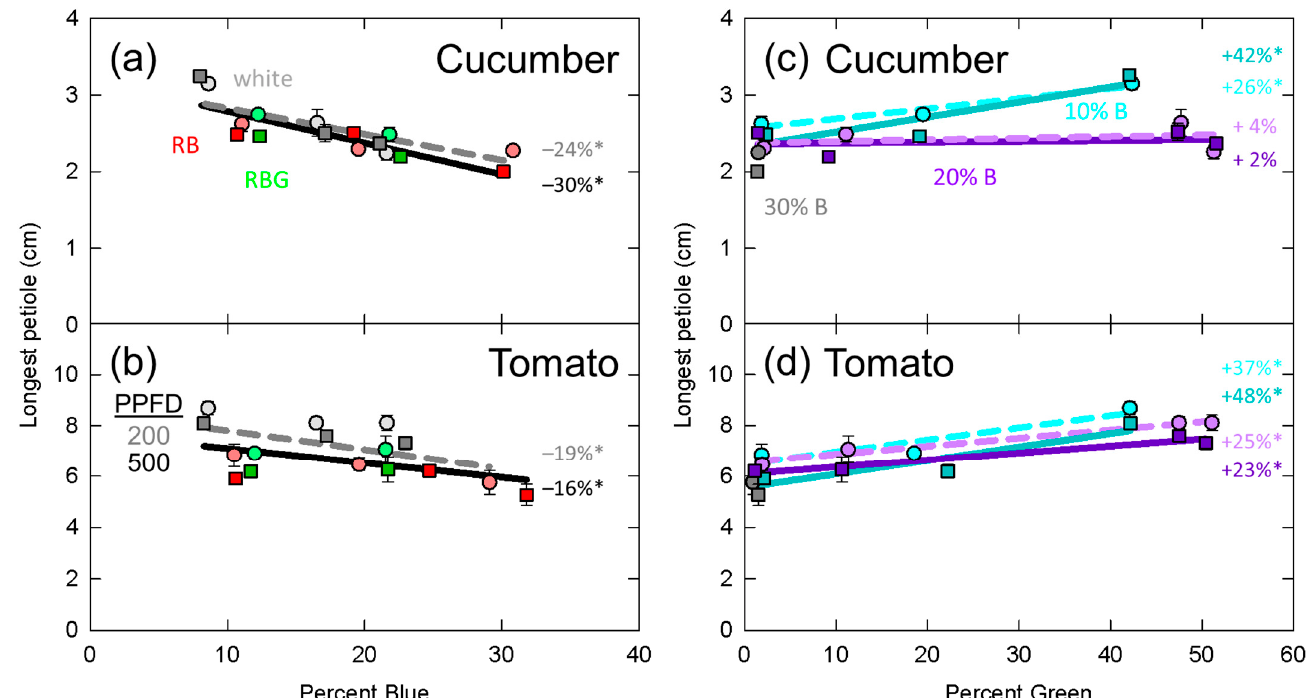
Figure 7. Effect of percent blue on longest petiole length in ( a ) cucumber and ( b ) tomato; and effect of percent green on longest petiole length in ( c ) cucumber and ( d ) tomato. * represents a significant effect of percent blue or percent green at the p < 0.05 level. See Figure 3 for the meaning of specific labels. Error bars represent normalized standard error of n = 3 replicates.